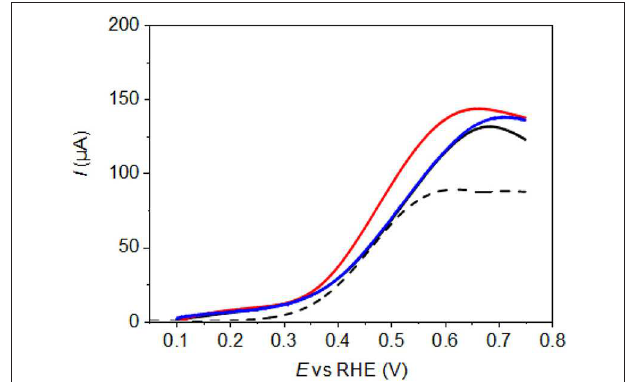
FIGURE 4 | Polarization curves recorded for the electrooxidation of glucose 10 − 1 mol L − 1 in NaOH 10 − 1 mol L − 1 aqueous electrolyte (T = 293K, scan rate = 5mV s − 1 ) on unmodified Pd-NPs. – for Pd-NS, – for Pd-NC and – for Pd-NO; - - activity of pure Au